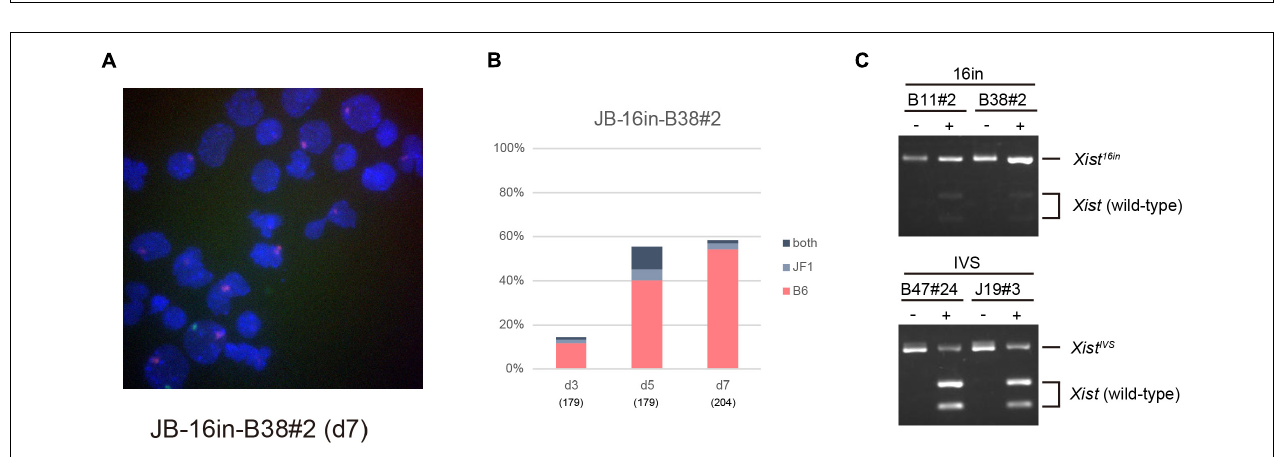
FIGURE 4 | RNA-FISH in differentiating ESCs heterozygous for either Xist CAG 16 in 2 lox or Xist CAG 16 in . Expression of Xist and Atrx was examined in respective differentiating ESCs for day 3 (d3) up to day 7 (d7). Each cell line examined (16in-2L-B11, 16in-B11#2, 16in-2L-B38, and 16in-B38#2) carried the targeted Xist allele on the X B6 . The number of nuclei examined is indicated in parentheses under each day point.